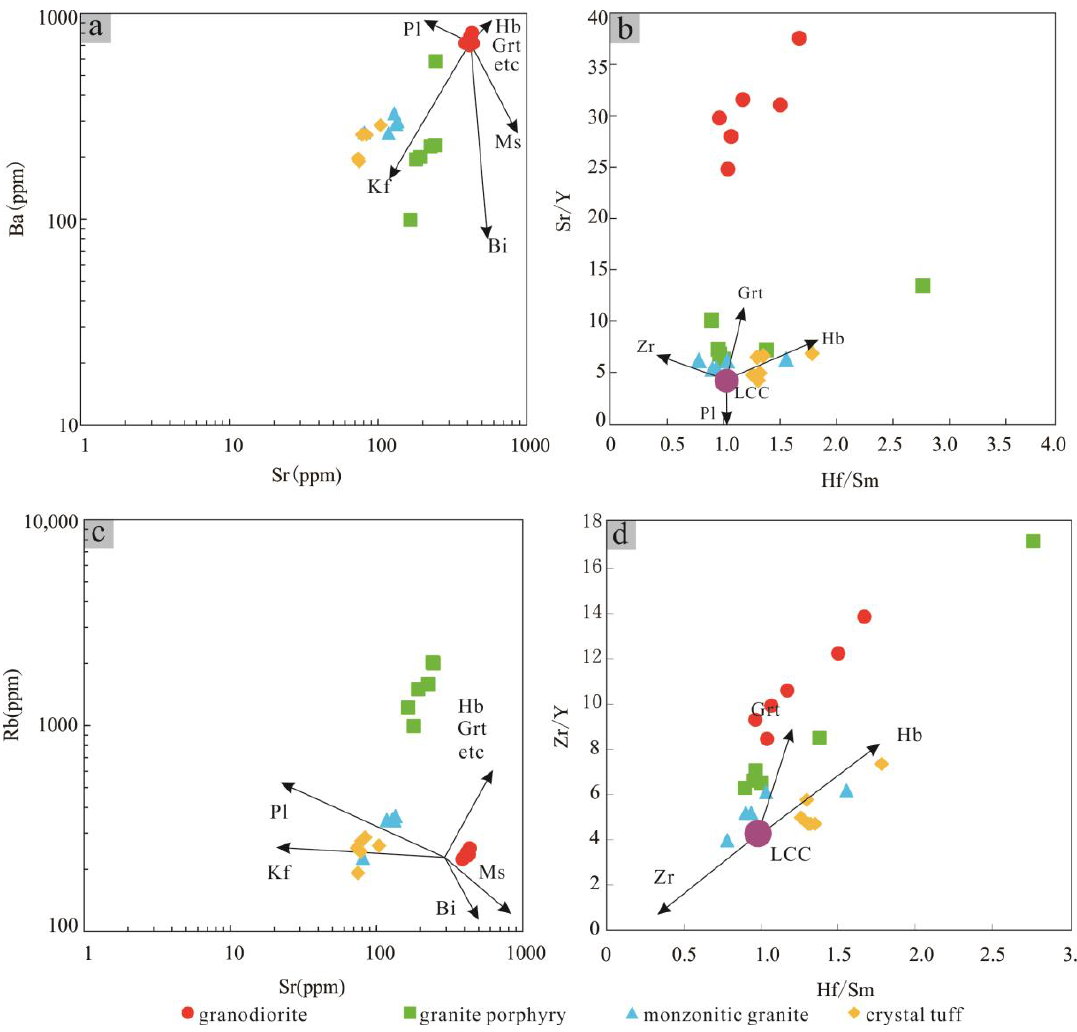
Figure 10. ( a ) Ba–Sr, ( b ) (Sr/Y)–(Hf/Sm), ( c ) Rb–Sr, and ( d ) (Zr/Y)–(Hf/Sm) diagrams for Hutouya deposit granitic rocks and crystal tuff.